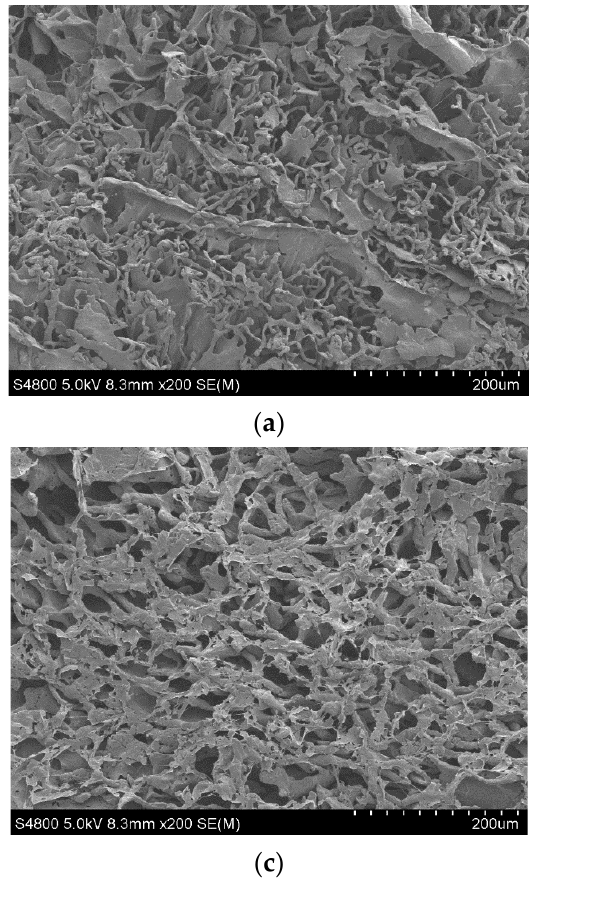
Figure 2. SEM micrographs × 200 of PCL nanocomposite scaffolds: ( a ) PCL; ( b ) PCL/0.3% rGO; ( c ) PCL/0.6% rGO; ( d ) PCL/1%